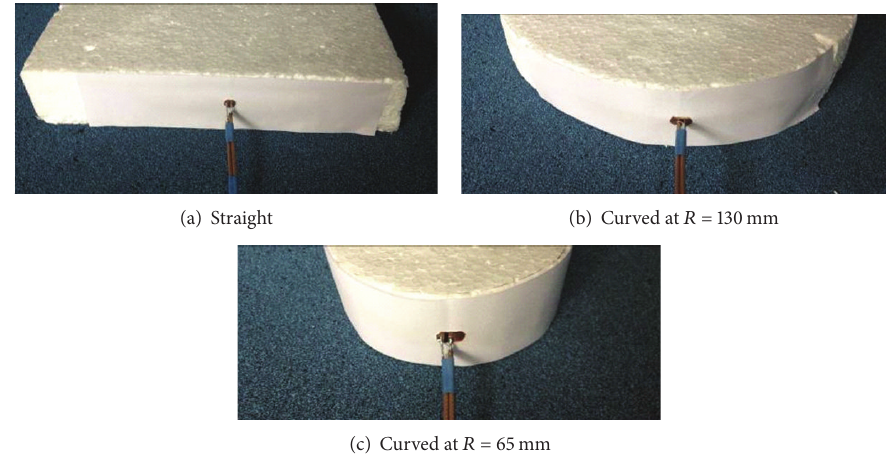
Figure 17: Multilayer strip dipole antenna with balun and cover paper used for measurement.